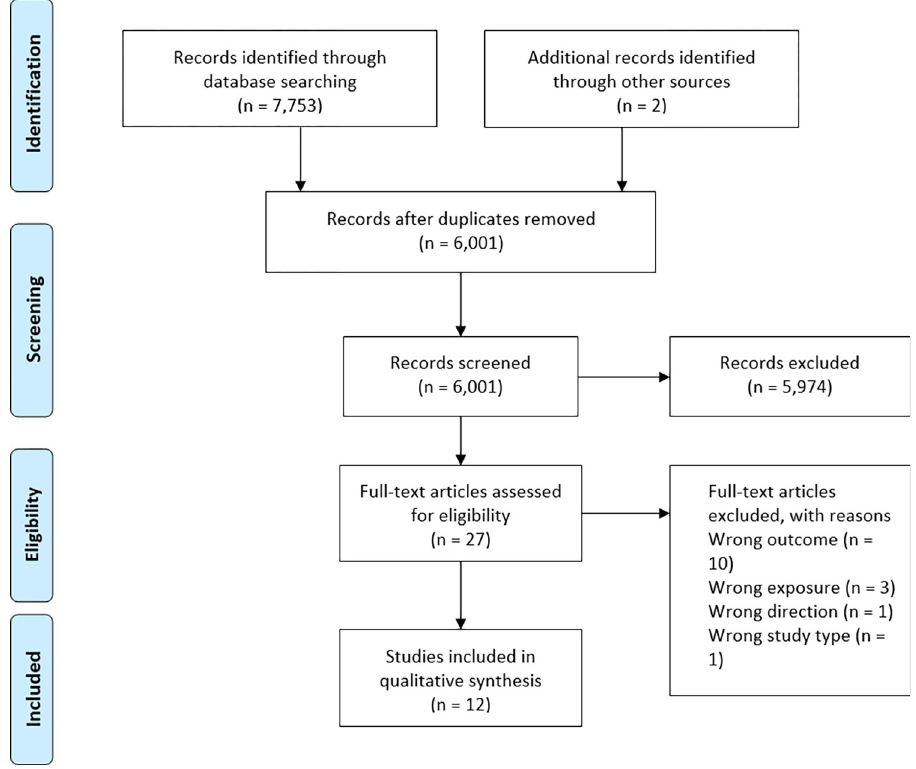
Fig 1. Modified PRISMA flow diagram of literature search and study selection